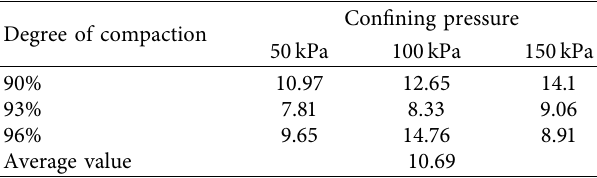
Table 4: Absolute value of relative error of lateral strain (%). Degree of